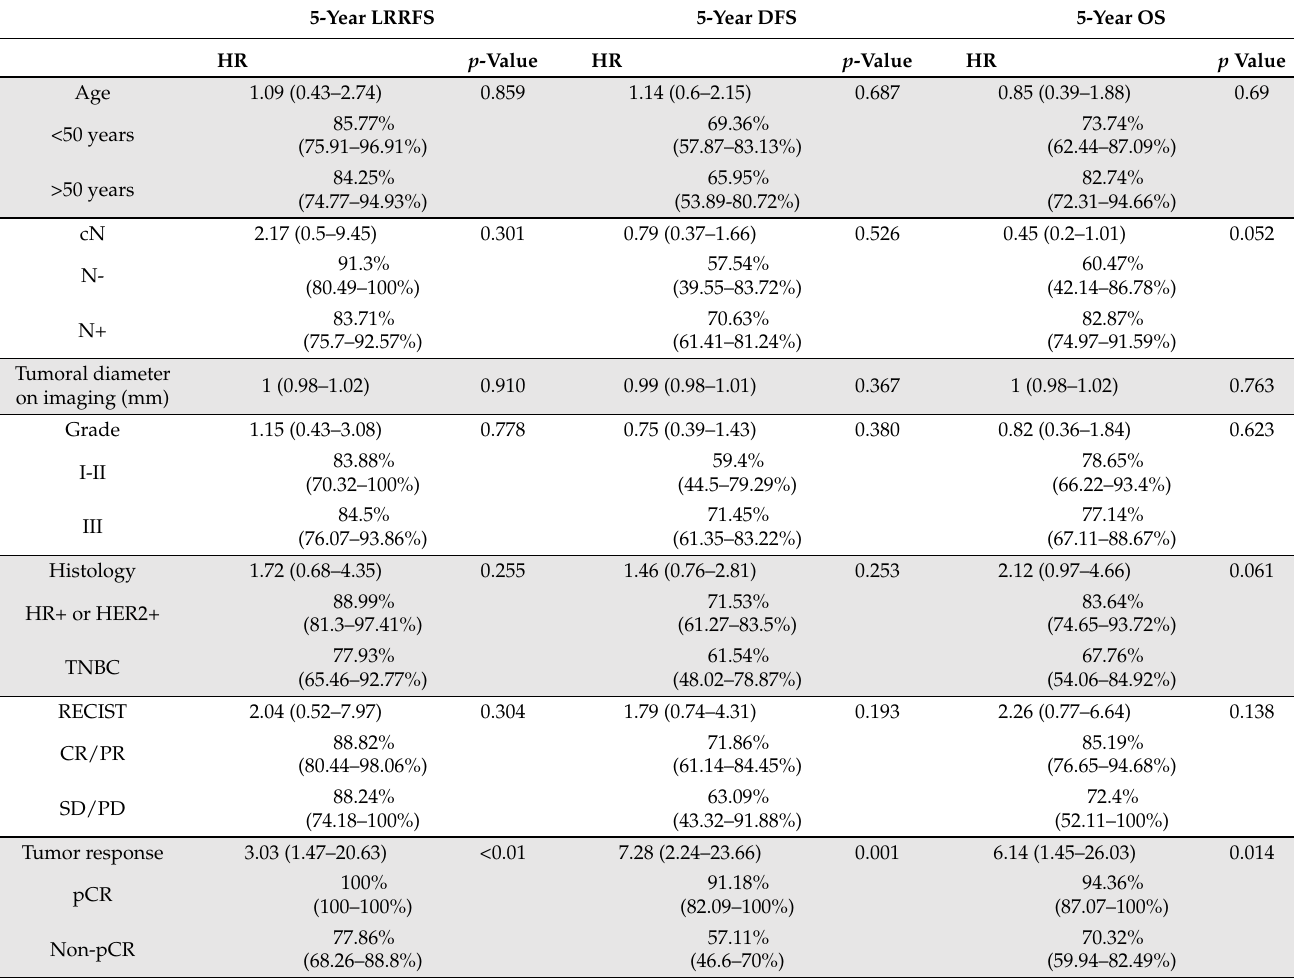
Table 3. Univariate analyses of prognostic factors for locoregional recurrences, disease-free survival, and overall